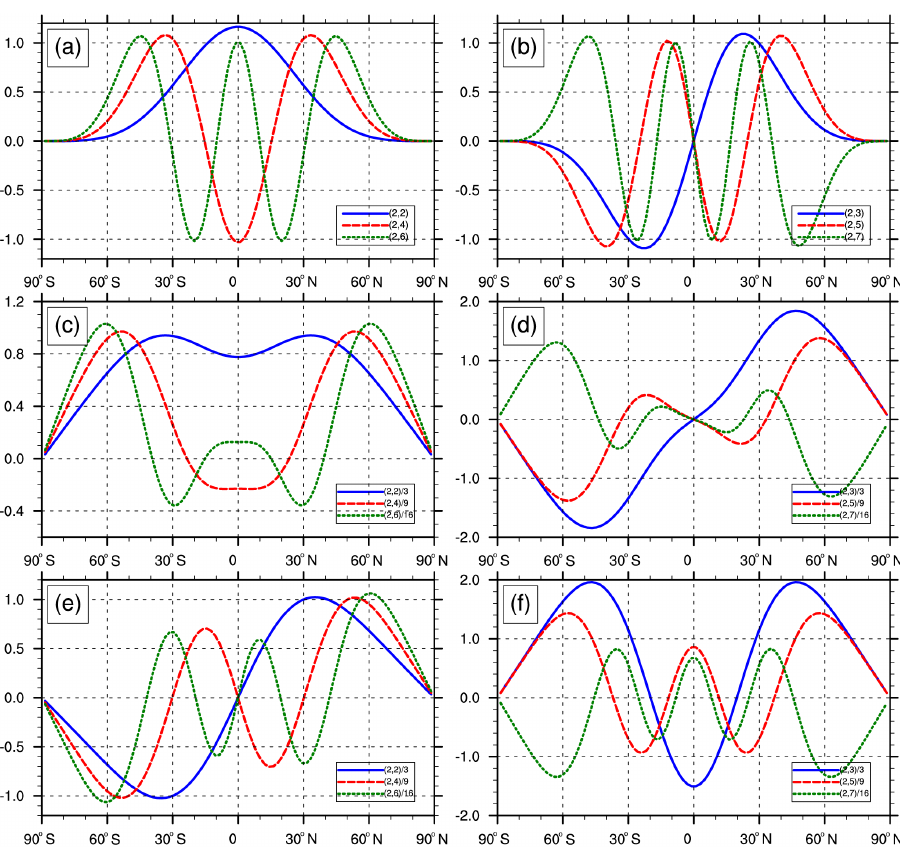
Figure 2. The first few symmetric and anti-symmetric Hough modes for SW2 ( s = 2, σ = 1), computed using the normalized ALP expan- sions. The left panels are symmetric modes, and the right panels are anti-symmetric modes, except panels (e, f) which are reversed. Panels (a, b) are for the scalar fields, (c, d) for the zonal wind component, and (e, f) for the meridional wind component. The labels are conventional.